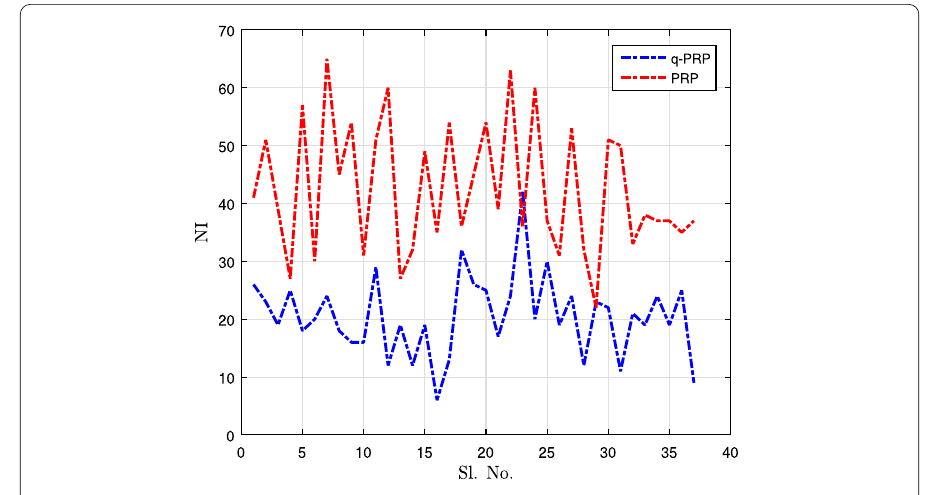
Figure 3 Graphical representation of q -PRP and PRP algorithms based on Tables 2 and 3